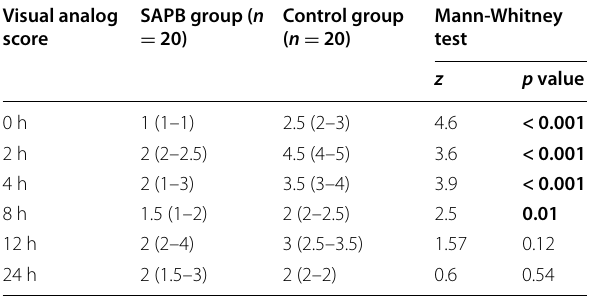
Data expressed as range, median; IQR Inter-quartile range, z Mann-Whitney test, SAPB Serratus anterior plane block